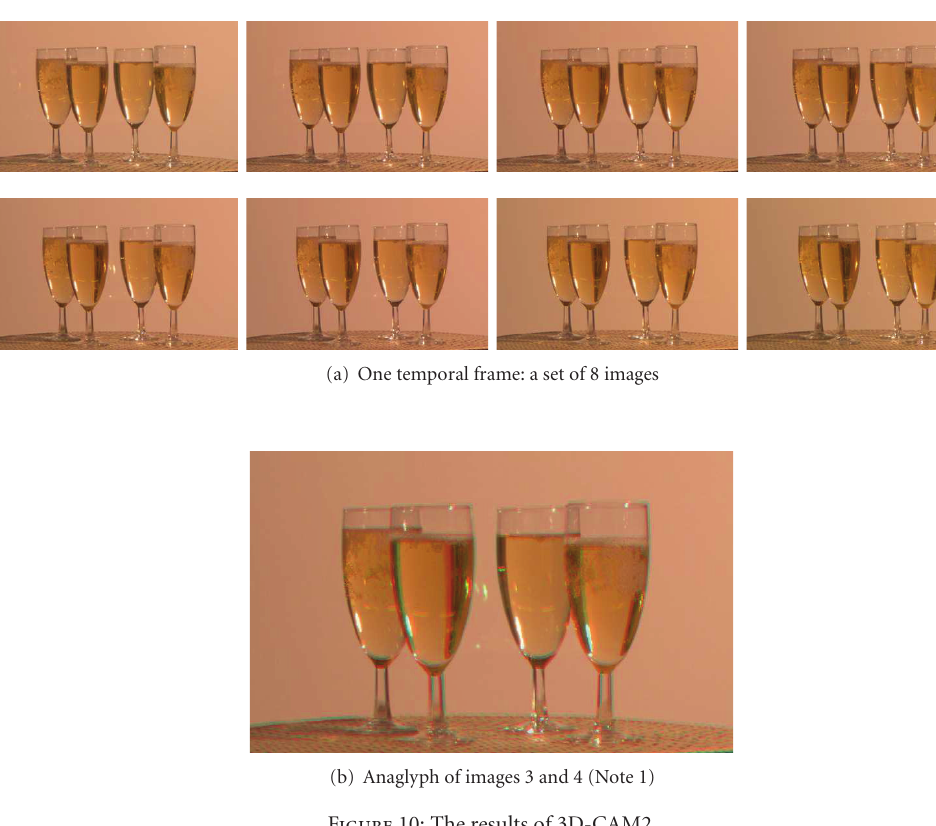
Figure 10: The results of